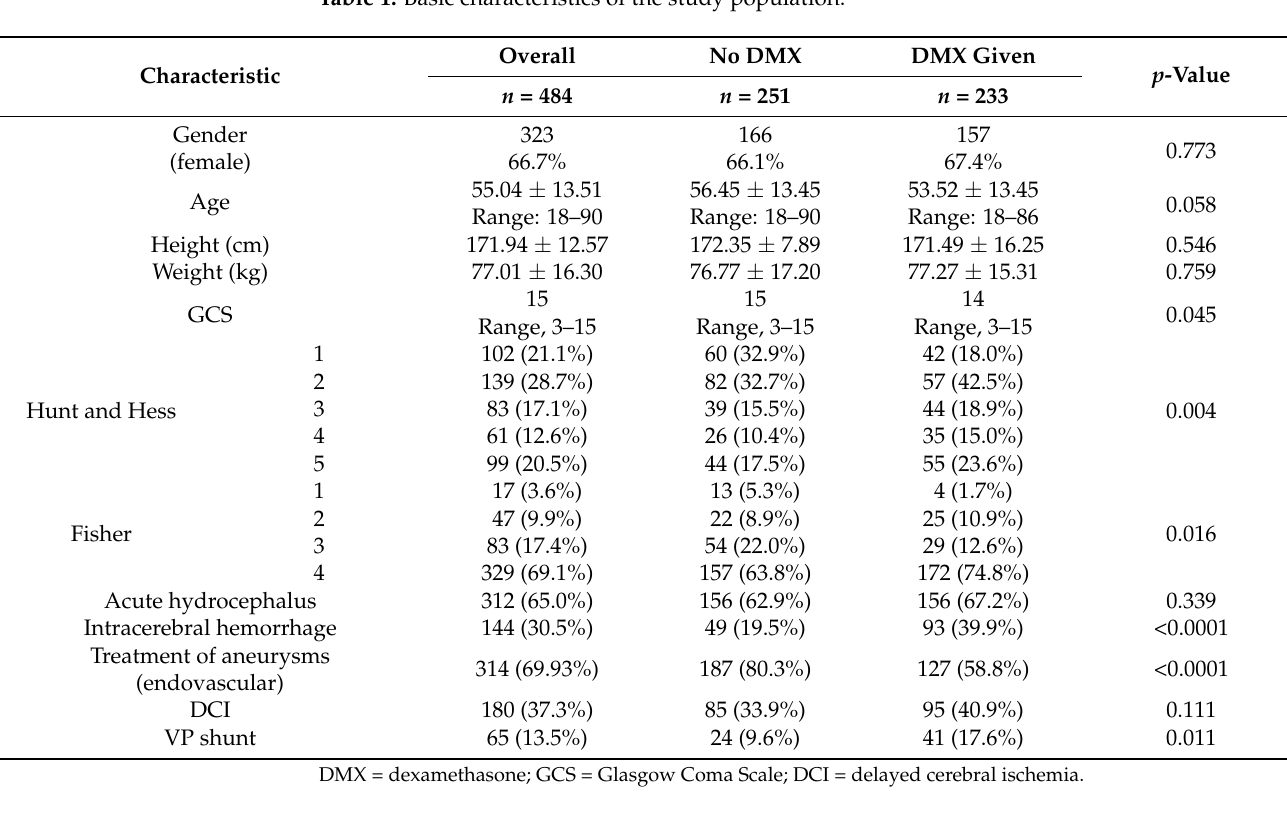
Table 1. Basic characteristics of the study population.